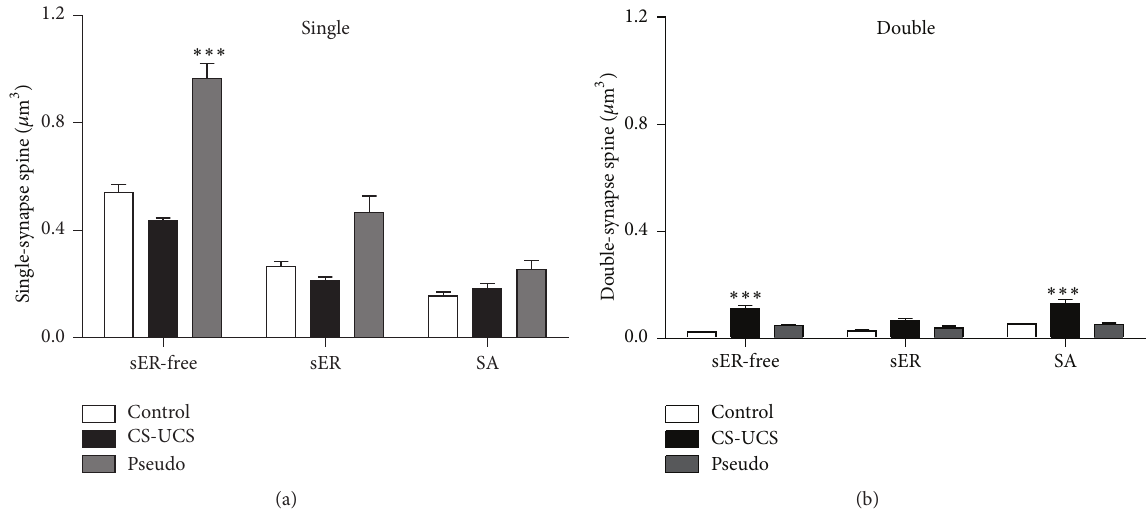
Figure 2: Density of single- (a) and double-synapse spines (b): sER-free, containing sER, and containing spine apparatus (SA). The graphs show means ± SEM (one-way ANOVA with post hoc Tukey’s test, ∗∗∗ 𝑃 < 0.001